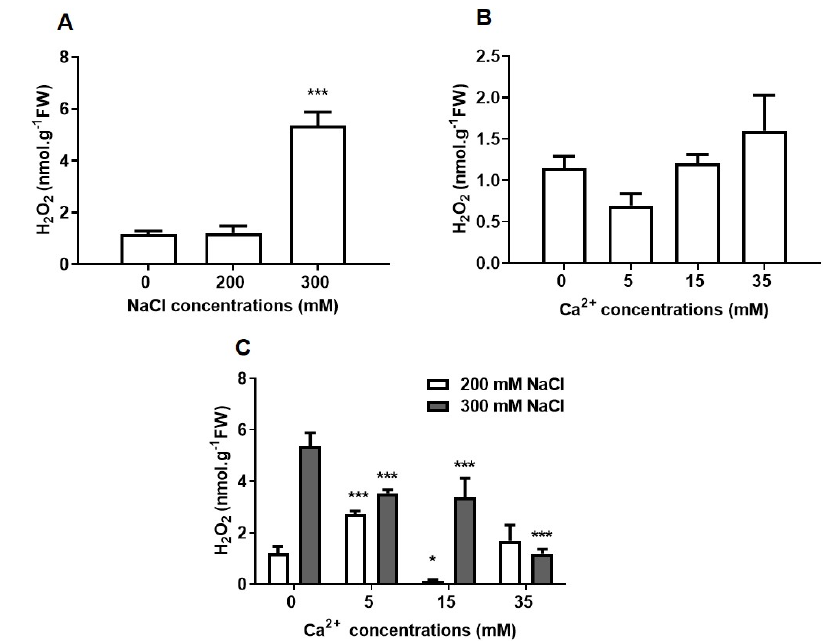
Figure 4. Effect of NaCl and Ca 2+ on H 2 O 2 content of sorghum seedlings. ( A ) H 2 O 2 content measured from seedlings germinated in the presence of different NaCl concentrations only. ( B , C ), Seedlings under different NaCl and Ca 2+ (5, 15 and 35mM) concentrations; ( B ) 0 mM, ( C ) 200 and 300 mM NaCl. Error bars represent the SD calculated from three biological replicates. Statistical significance between control and treated plants was determined using two-way ANOVA conducted on GraphPad Prism 8.4.2, shown as *** = p ≤ 0.001 and * = p ≤ 0.05 according to the Bonferroni’s multiple comparison test.